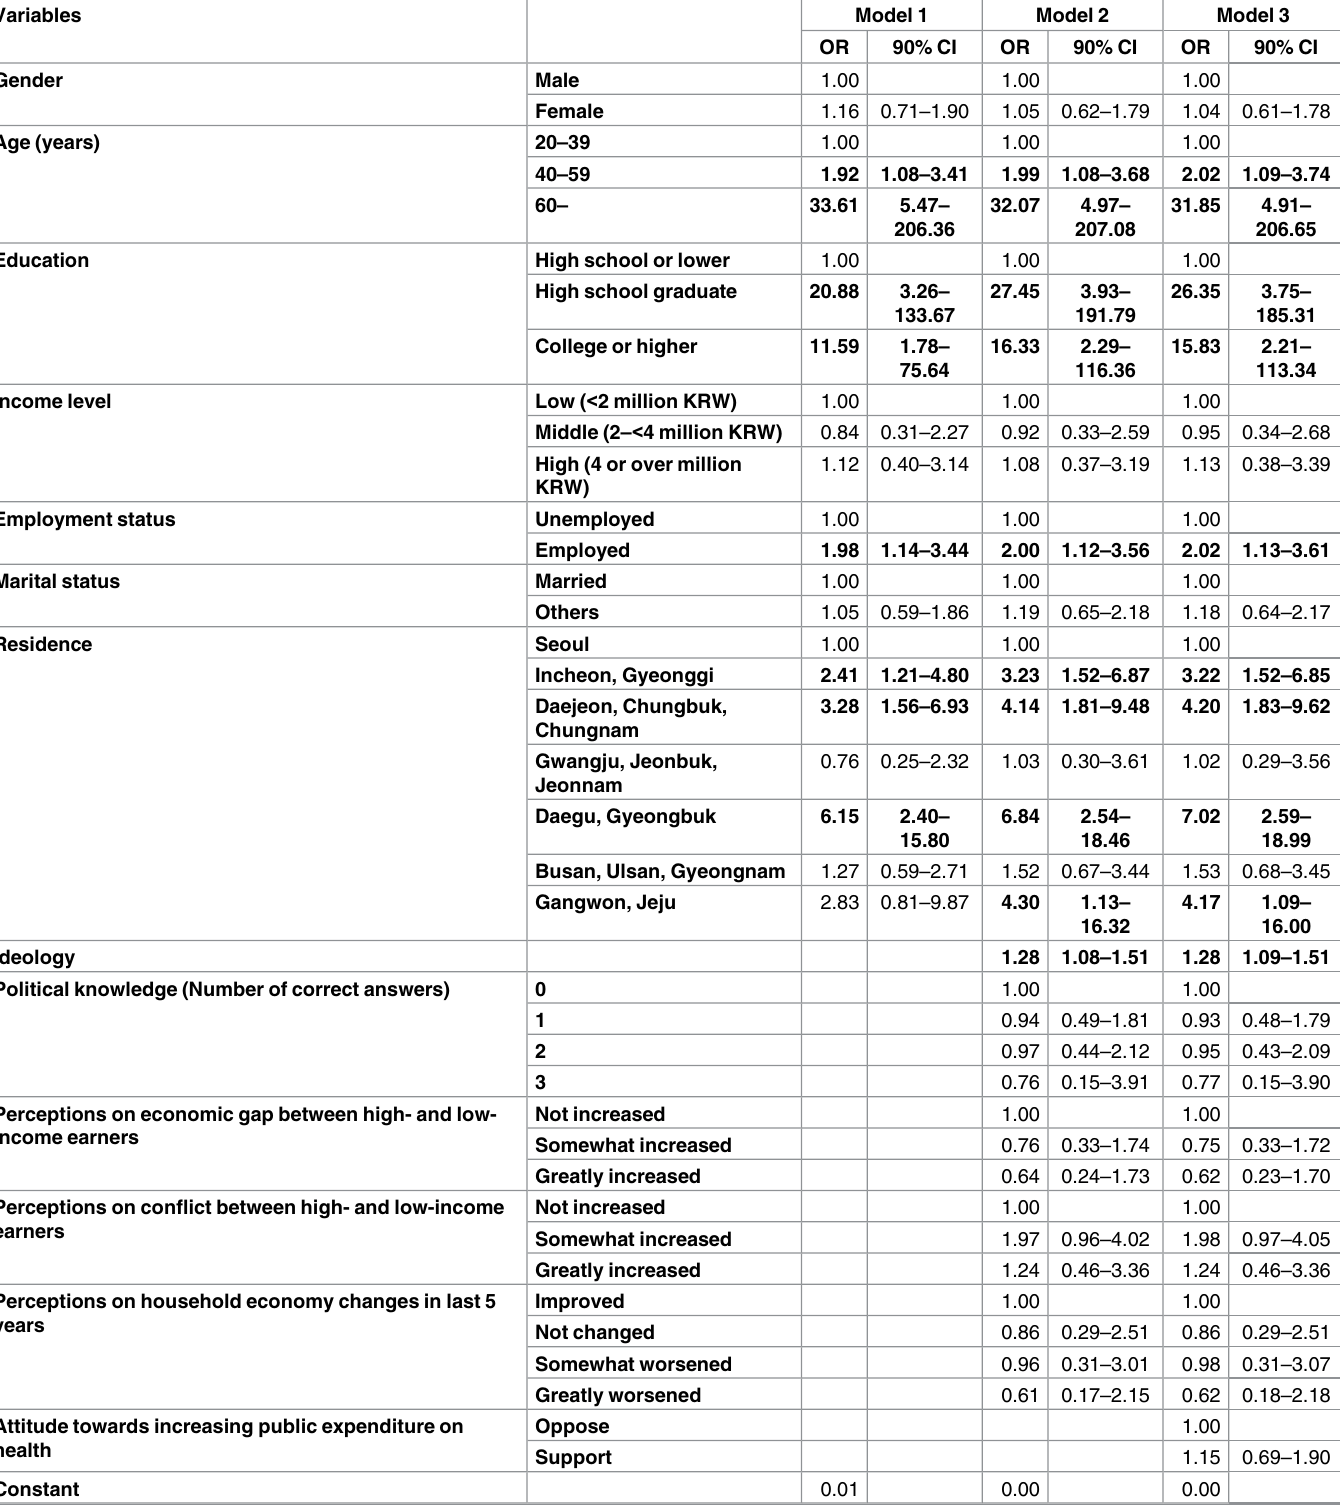
Table 4. Factors Affecting Vote for the Conservative Presidential Candidate among Party